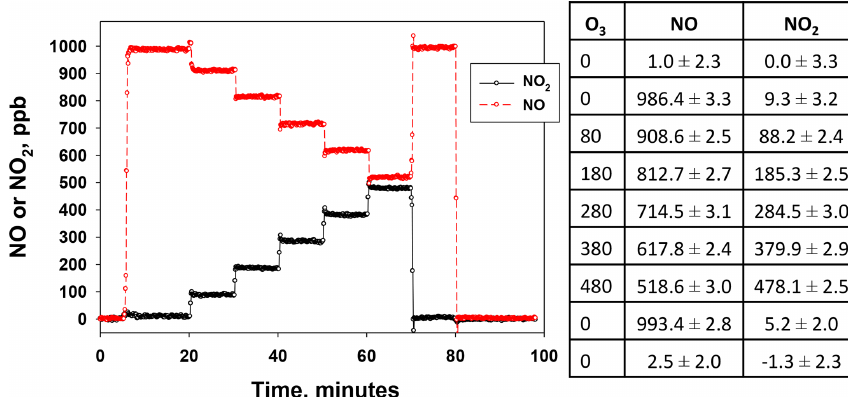
Figure 10. NO and NO 2 measured from the output of a Model 714 GPT calibrator. At time 5min, NO was set to 1000ppb. At time 20min, ozone was added and set points were varied between 80 and 480ppb in steps of 100ppb (this allowed for visual clarity of both NO and NO 2 at the highest [O 3 ]). O 3 was changed every 10min. Finally, data for [O 3 ] = 0 and [NO] = 0 were repeated for completeness. NO and NO 2 were measured using a calibrated 2B Tech Model 405.